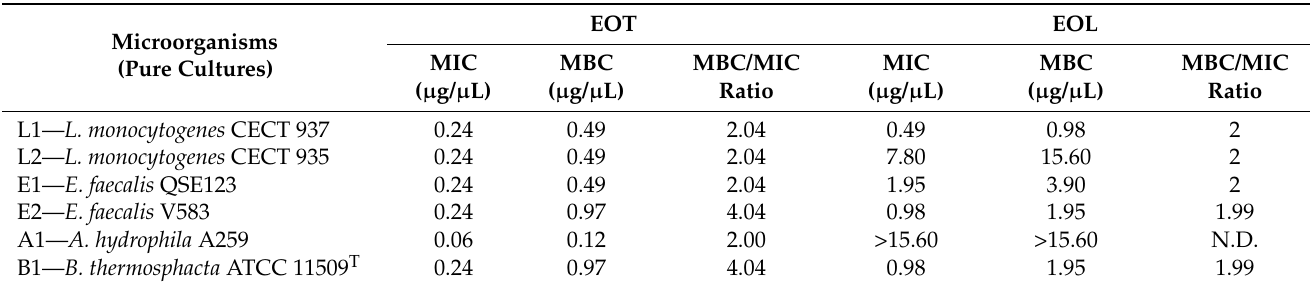
Table 5. Minimum inhibitory concentration and minimum bactericidal concentration of the antimi- crobial compounds against the microorganisms under study (pure